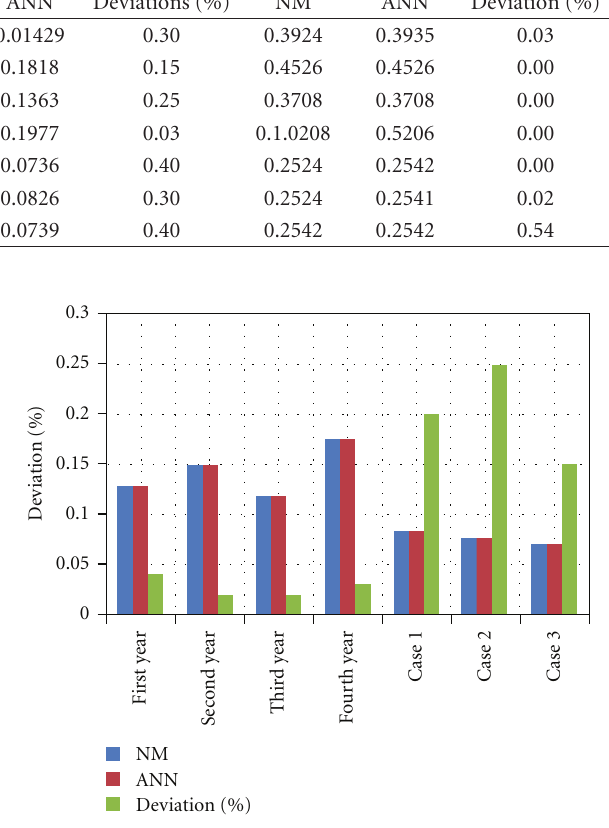
Figure 4: SAIFI values for feeder whole system with deviation less than 0.55.